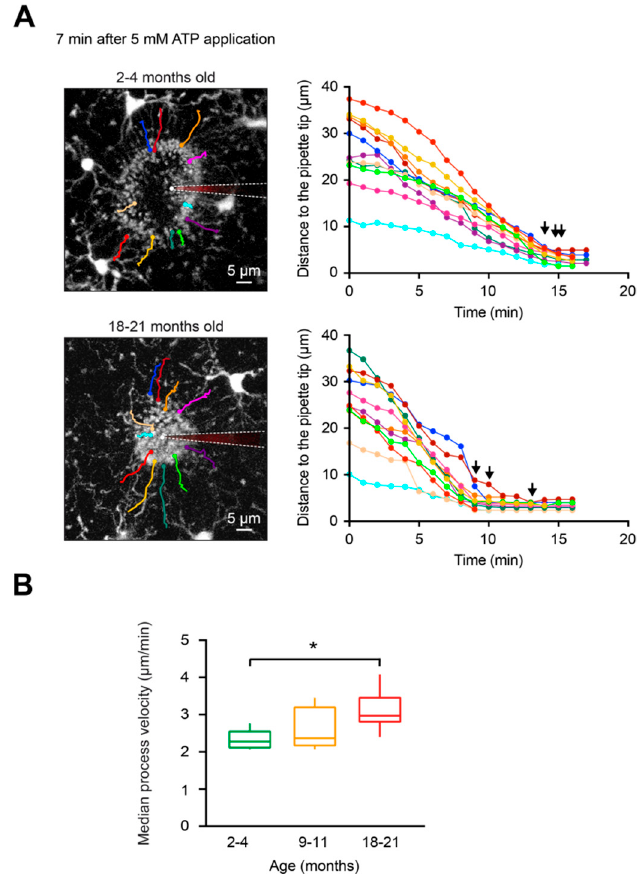
Figure 5. Extension of individual microglial processes involved in the formation of the containment around the ATP-containing pipette. ( A , left) MIP images of Z stacks of a 2- (top) and 18- (bottom) month-old mouse at 87–107 µ m and 82–102 µ m below the cortical surface, respectively, illustrating the shape of the containment 7 min after application of 5 mM ATP. The moment of the ATP application is taken as time point 0. Color lines illustrate trajectories of deliberately chosen individual microglial processes extending toward the pipette tip. White dashed lines emphasize the locations of the ATP-containing pipettes. ( A , right) Graphs illustrating the changes in distances of the selected (color-coded as in A, left) microglial processes to the pipette tip over time. Please note that in 18–21-month-old mice the time points at which individual microglial processes reached their final destination (black arrows) scattered much more compared to 2–4-month-old mice. ( B ) Box-and-whisker plot illustrating median (per mouse) process velocity in microglia from 2–4 (green), 9–11 (orange) and 18–21 (red)-month-old mice. Median process velocity in 18–21-month-old mice was significantly higher compared to that in 2–4-month-old mice ( p = 0.03 for 2–4- vs. 18–21-month-old mice, p = 0.95 for 2–4- vs. 9–11-month-old mice and p = 0.39 for 9–11- vs. 18–21-month-old mice, Kruskal–Wallis test; n = 5, 5, 6 mice for 2–4-, 9–11-, and 18–21-month-old mice, respectively). * p < 0.05 in ( B